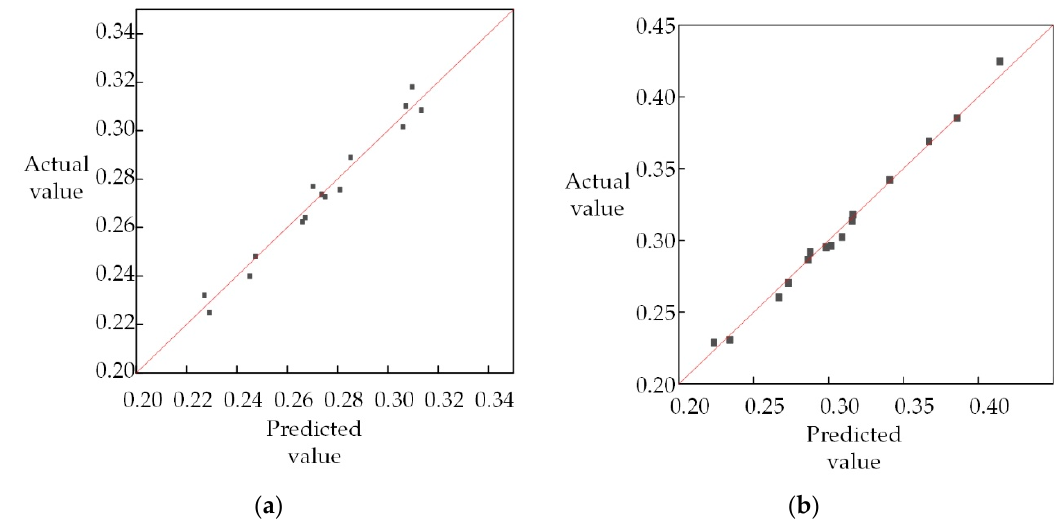
Figure 9. Error analysis. ( a ) Efficiency; ( b ) head ratio .